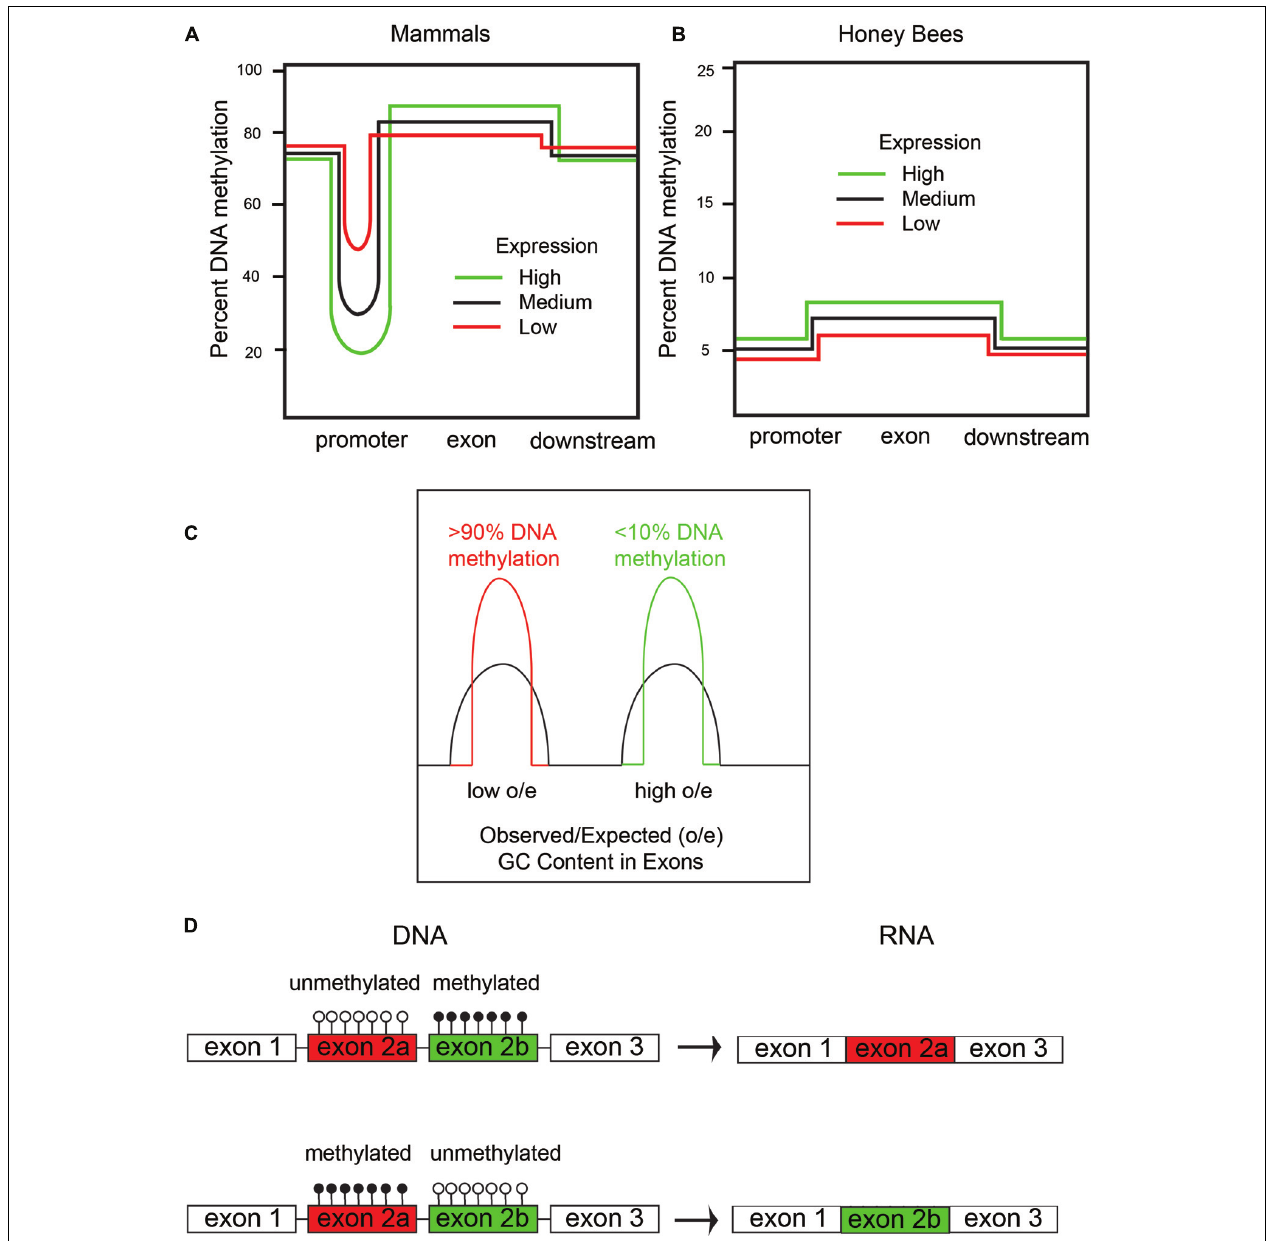
housekeeping genes with low observed/expected (o/e) CG content and high amounts of DNA methylation, and (2) caste-specific and